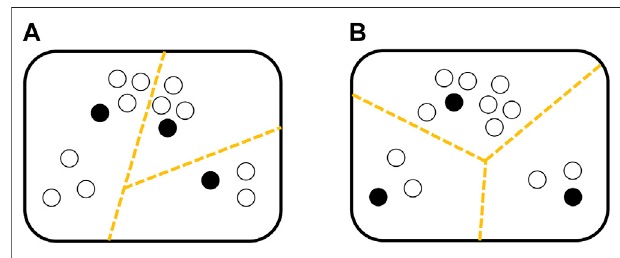
FIGURE 6 | Difference clustering performance between K-means algorithm (A) and K-means + algorithm (B) , where (B) seems more